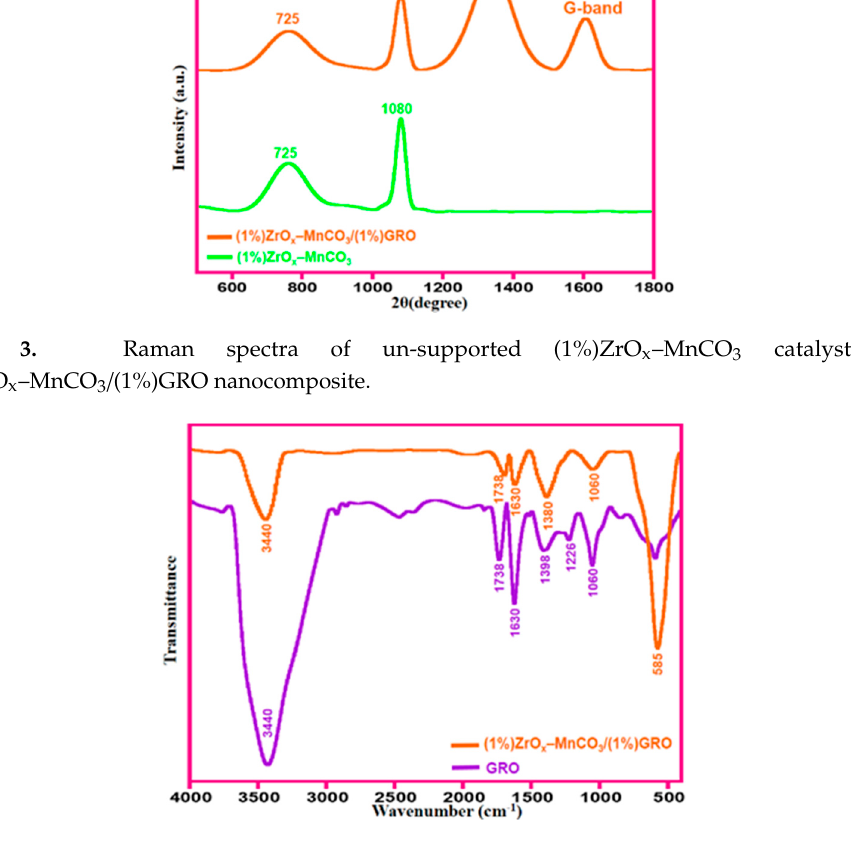
Figure 4. FT-IR spectra of GRO and (1%)ZrO x –MnCO 3 /(1%)GRO nanocomposite.